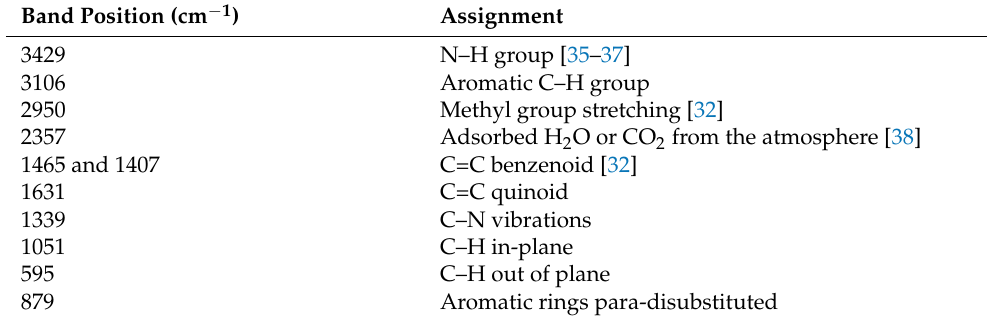
Table 1. The FT-IR analysis of the PMT nanomaterial.